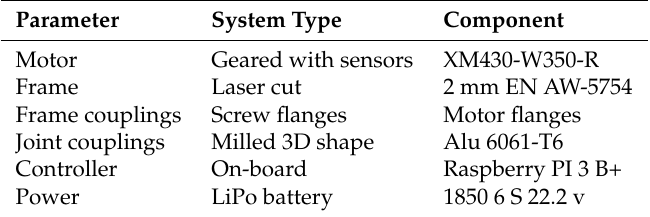
Table 2. Selected components and